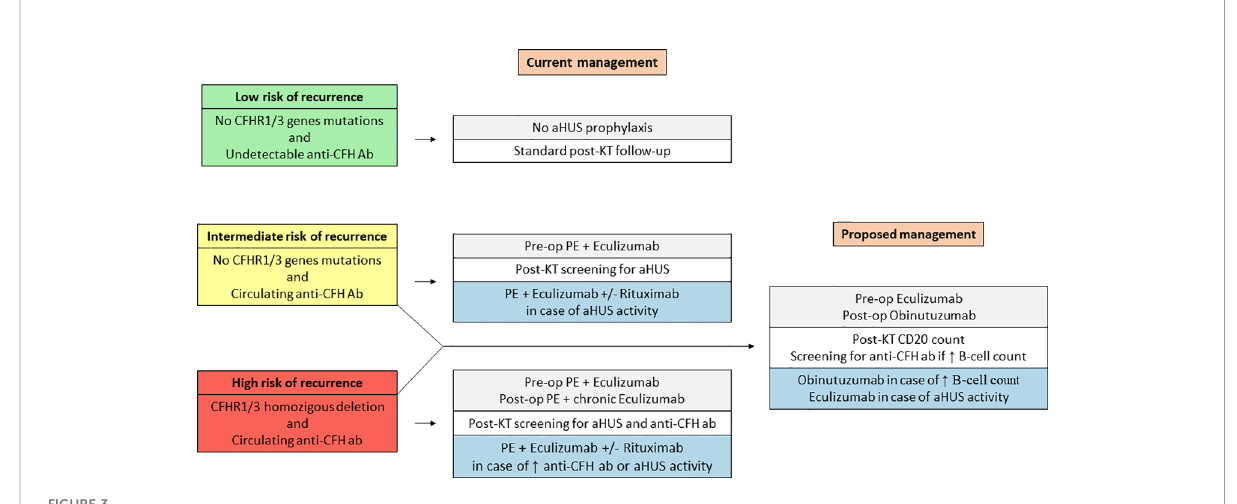
FIGURE 3 Current and proposed management of kidney transplant recipients with